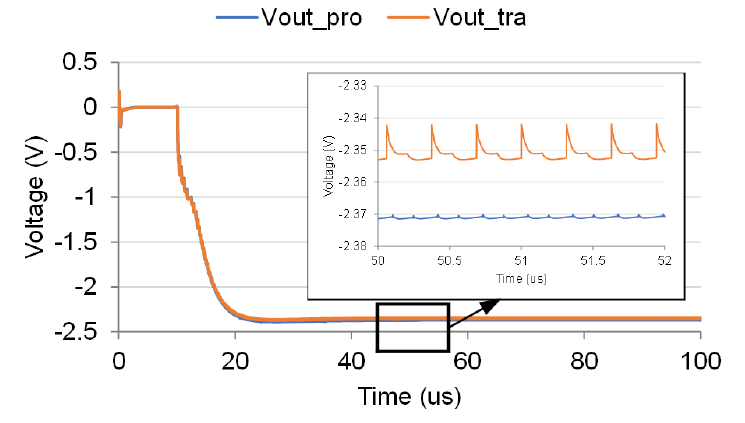
Figure 9. Post-layout simulation results of the output voltage with and without the proposed